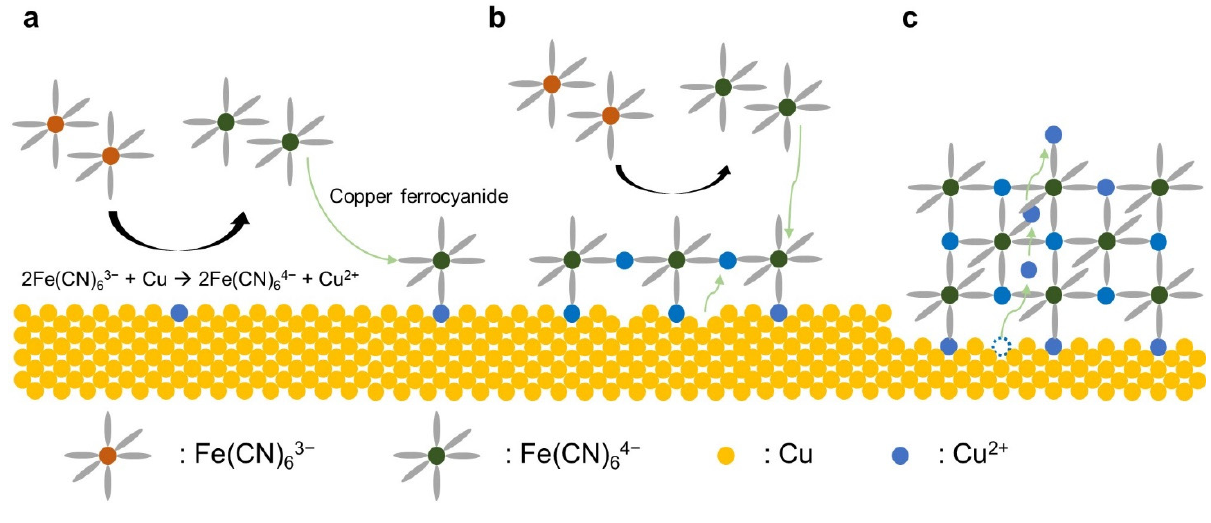
Nanomaterials 2021 , 11 , x FOR PEER REVIEW Figure 1. Schematic of a CuHCFe thin film deposition by corrosion of copper metal thin film in a K 3 Fe(CN) 6 solution: ( a ) copper oxidation and copper ferrocyanide formation, ( b ) thin film formation, and ( c ) growth of CuHCFe film.